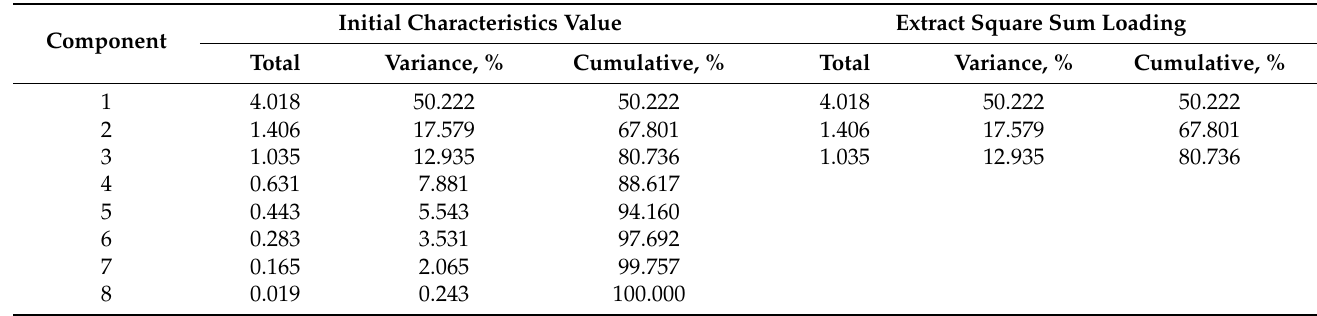
Table 5. Variance contribution analysis table.